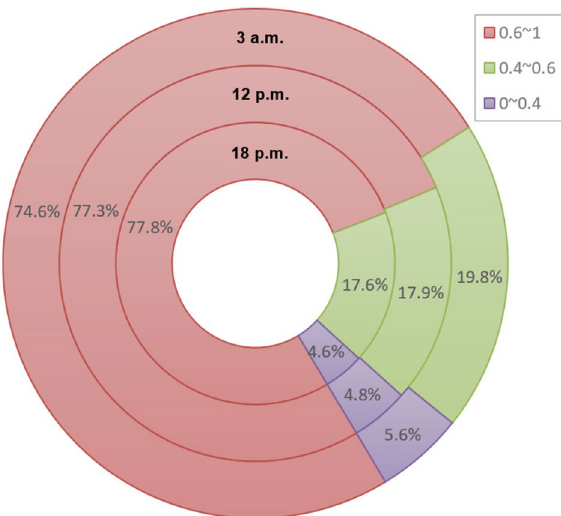
Figure 10. Cosine similarity of POLS